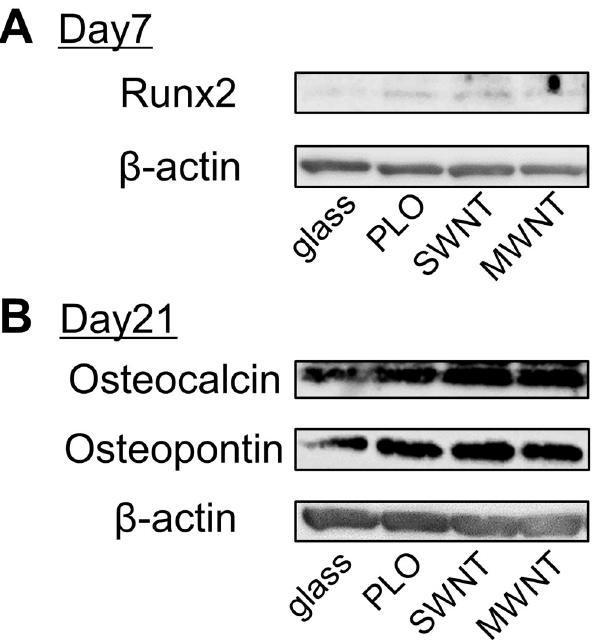
Fig 4. Expression of the proteins associated with osteogenic differentiation. Protein samples were made from MSCs incubated on uncoated glass, and glass coated with SWNT, MWNT and PLO for 7 days. The bands show the expressions of (A) Runx2 in the 6 μ g of protein samples obtained from MSCs incubated for 7 days, and (B) Osteocalcin and Osteopontin in the 11 μ g of protein samples obtained from MSCs incubated for 21 days.